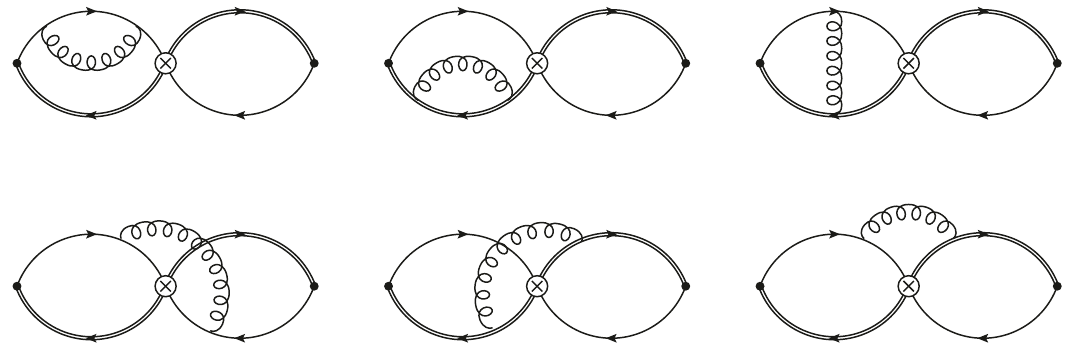
Figure 2 . Leading order diagram for the three-point HQET correlator (3.1). The sum over the two possible contractions of the operator ~ Q is implied.